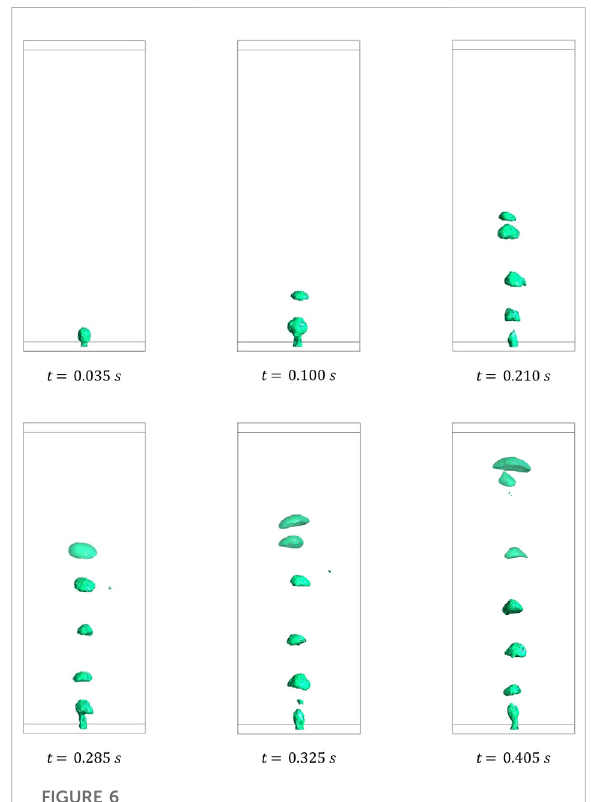
FIGURE 6 Snapshots of 3D simulation of bubbles released by gas injection in molten LBE, v g (cid:1) 1 m / s